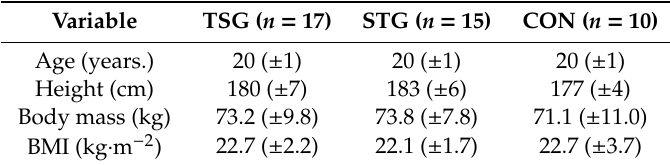
Table 1. Mean ( ± SD) age, height, body mass, and body mass index (BMI) in the study groups.